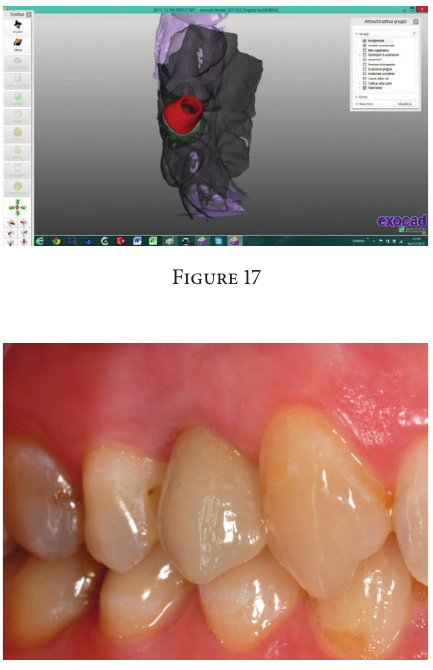
Figure 18: Screwing of the definitive crown. Vestibular view.